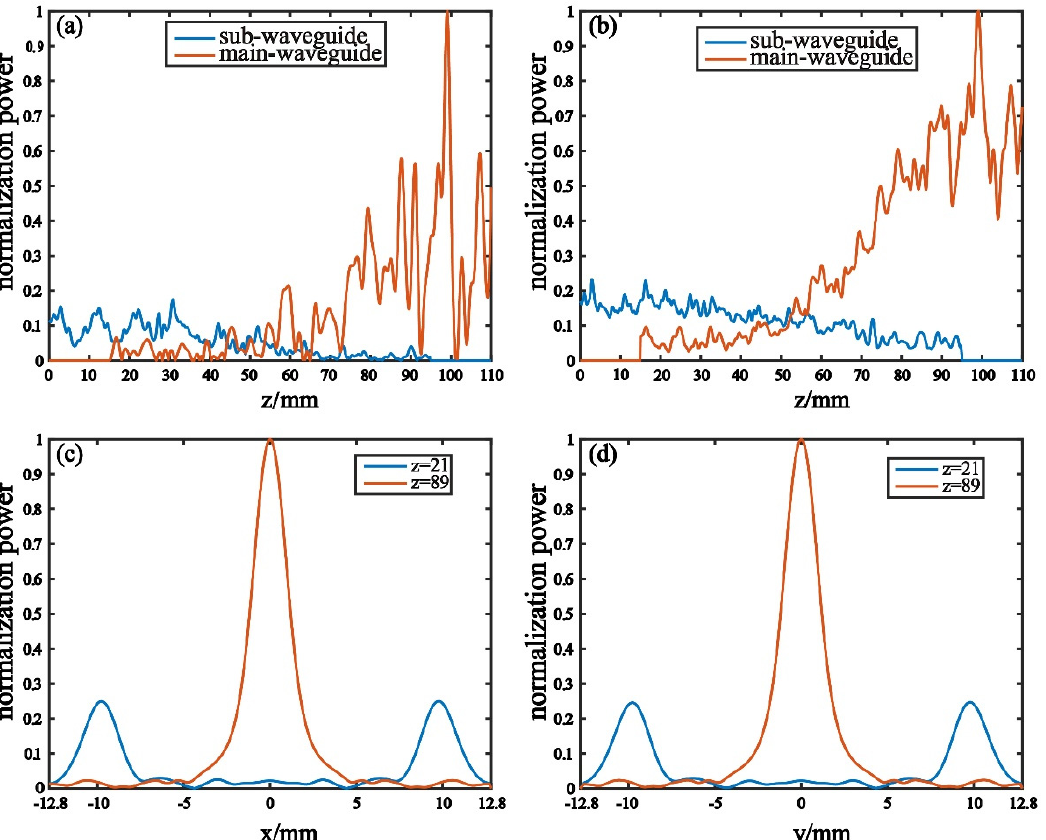
Figure 10. ( a ) The normalization power of the center of the main waveguide and sub-waveguide 1 along the z direction ( x = 0, y = 0 mm); ( b ) the normalization power of the main waveguide and sub-waveguide 1 along the z direction; ( c ) the blue line and the orange line are the variation of the center power of the combiner along the x direction at the beginning and at the end of the coupling slot, respectively; and ( d ) the blue line and the orange line are the variation of the center power of the combiner along the y direction at the beginning and at the end of the coupling slot, respectively. The electric field distributions in Figures 8 and 9 show that the four TE 11 -waves input to four input ports are largely coupled from sub-waveguides to the main waveguide. The power measured at the output port also shows that most of the power is combined and output in the main waveguide. It is observed that the variation of normalization power of sub-waveguides and main waveguide in Figure 10a,b is roughly consistent with the vari- ation of theoretical power in Figure 5d. It is proved that the model is a feasible method. 4. Discussion Several combiners with large size or low power in microwave and low frequency millimeter-wave are introduced in the Introduction section. Compared with these power combiners, the four-way power combiner in 94 GHz could increase output power by four times and has a structure with a small size, which is conducive to system miniaturization. The carried power capacity can reach MW level using circular waveguides based on spa- tial power-combining technology. A long and narrow coupling slot is employed, which facilitates the power coupled from sub-waveguides to the main waveguide. In addition, the sub-waveguides are located in the upper, lower, left, and right directions of the main- waveguide. The TE 11 -waves of different polarization directions are input. The structure has good isolation between sub-waveguides to achieve high power-combining efficiency. Nevertheless, the size of the coupling slot is small, which needs to be more precise in the